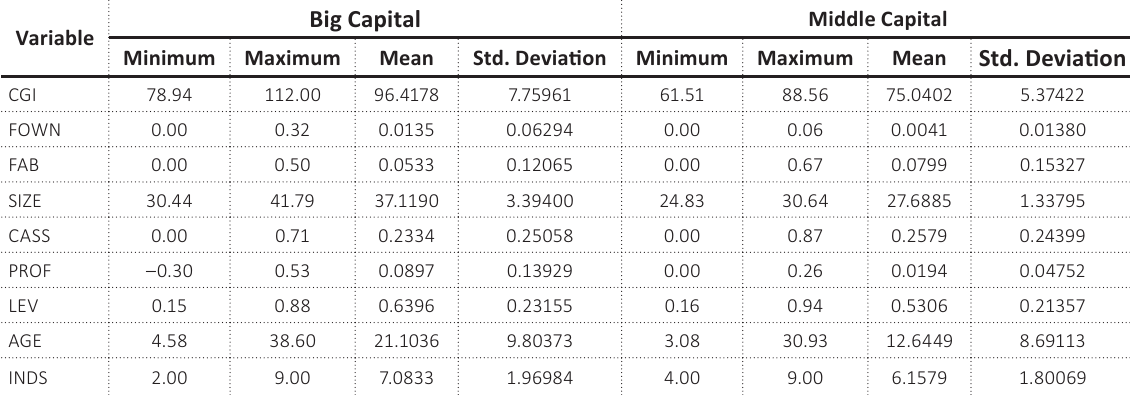
Table 4. Descriptive statistics ( H2